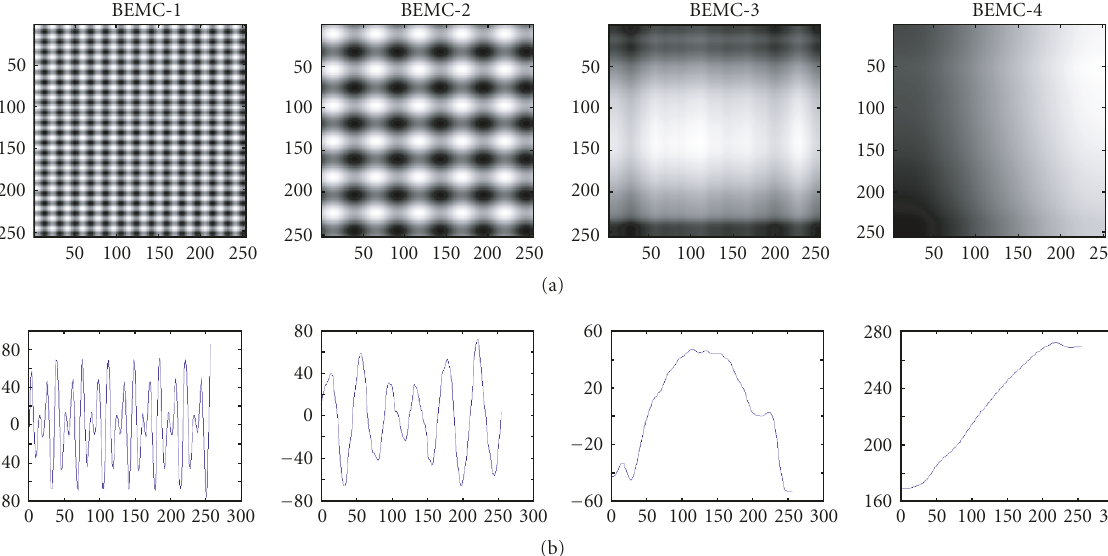
to the over sifting, an additional component appears that does not have any similarity to any of the original